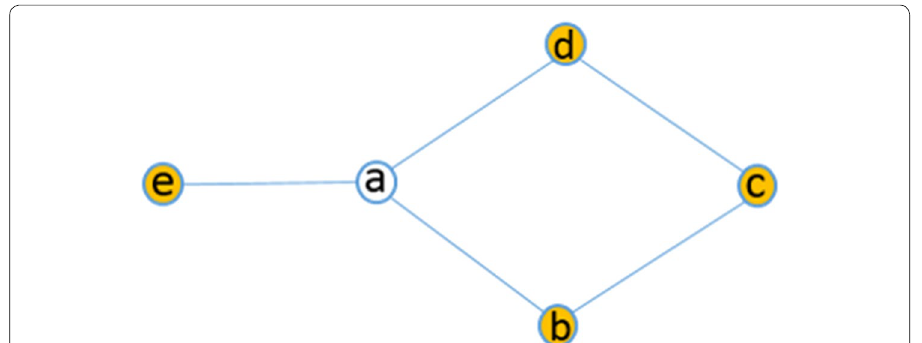
Fig. 3 Node betweenness centrality for node